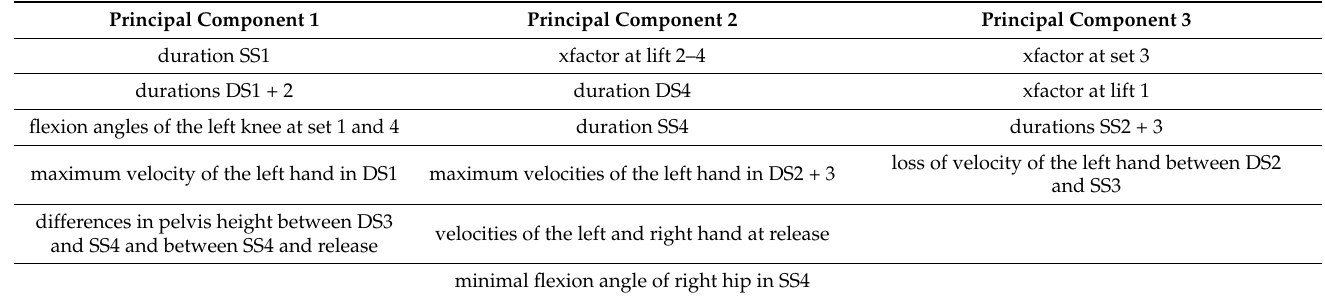
Table 4. Results of principal component